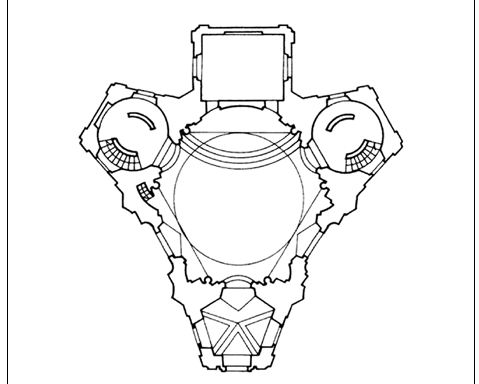
fig. 9. Panenské Břežany. Chapel of St. ann, Madonna and Child, j. B. Santini-ajchel, 1705– 1707. Ground floor plan. Source : Horyna, 1998: